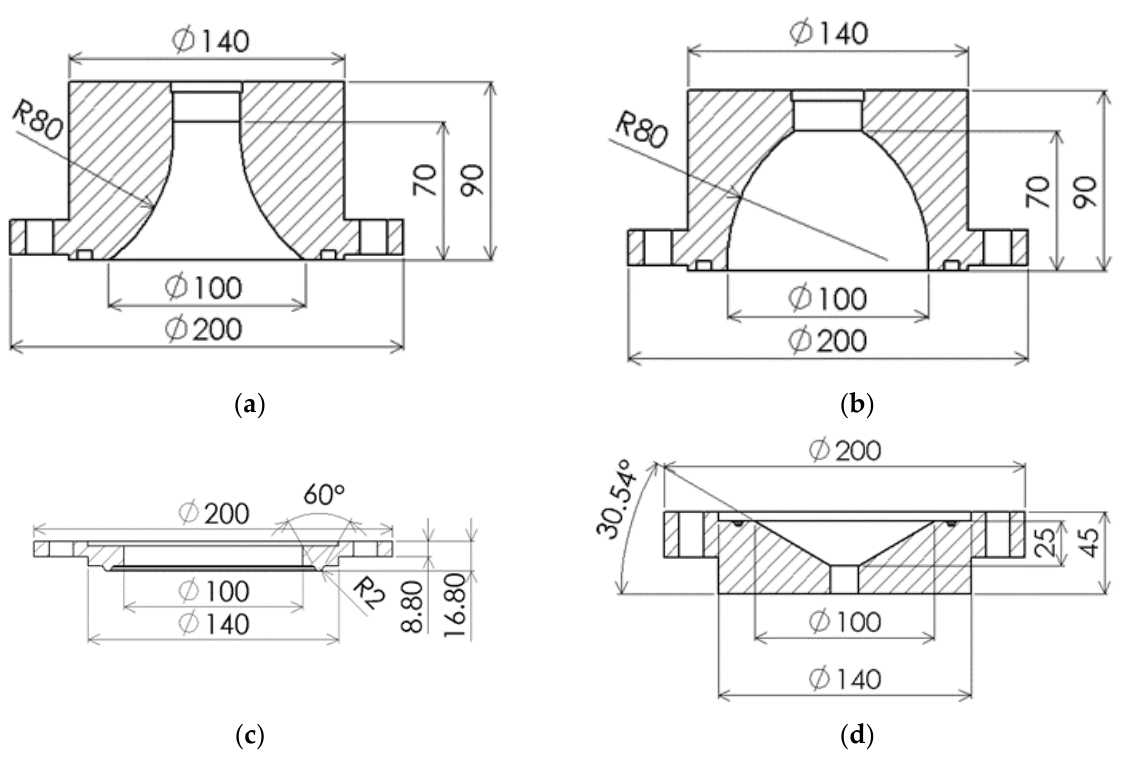
Figure 5. Cross-sectional view of the forming equipment. ( a ) Hyperbolic pressure vessel. ( b ) Parabolic pressure vessel. ( c ) Plate holder. ( d ) Die.